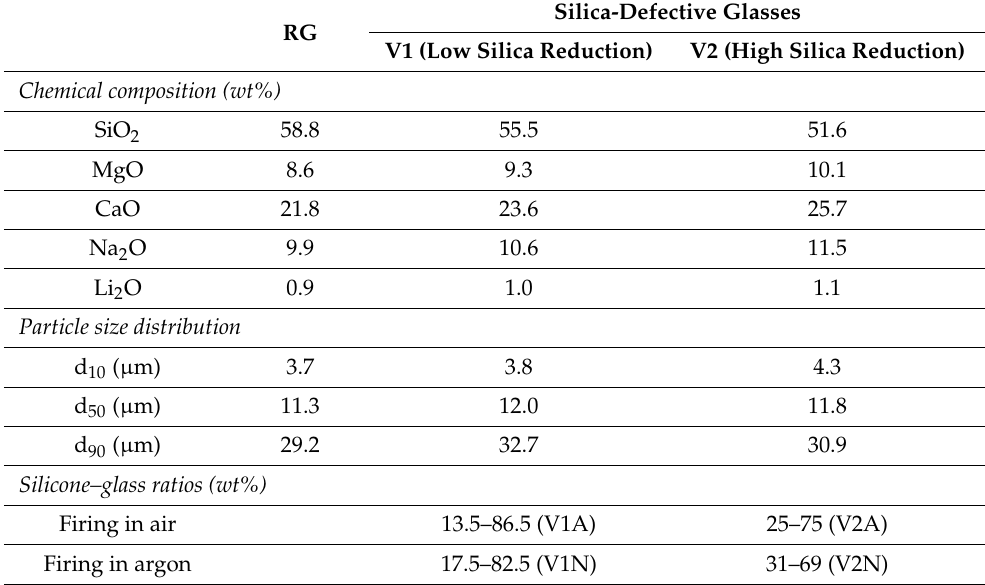
Table 1. Chemical composition of the studied glasses and glass–silicone ratios.